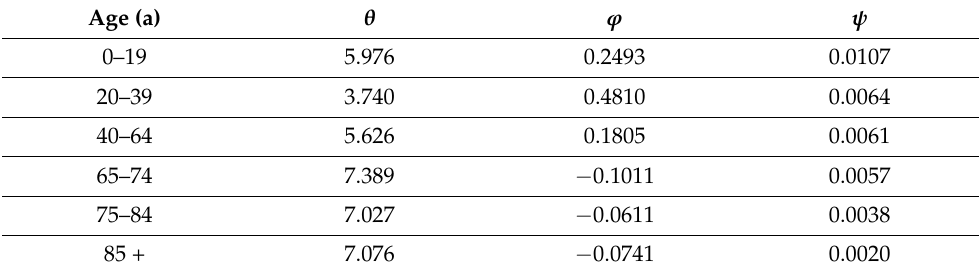
Table A4. Parameters for glycated haemoglobin function.